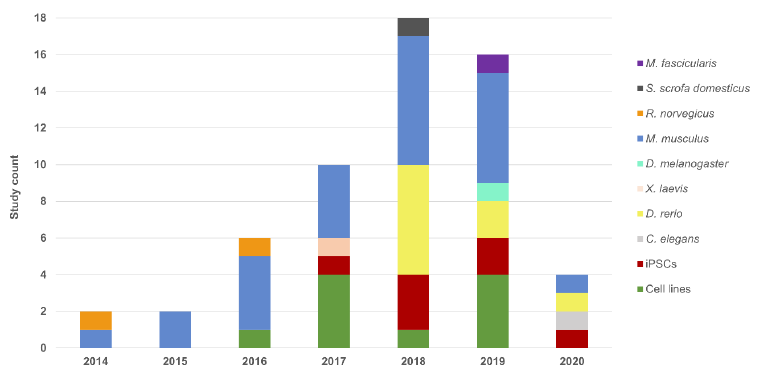
Figure 1. Chart of Inherited Retinal Dystrophies (IRD) related studies using the CRISPR technology for variant interpretation and disease modeling. A growing trend in the number of works that use this editing system is observed from the year 2014 to the first quarter of 2020, as well as a diversification in terms of the models